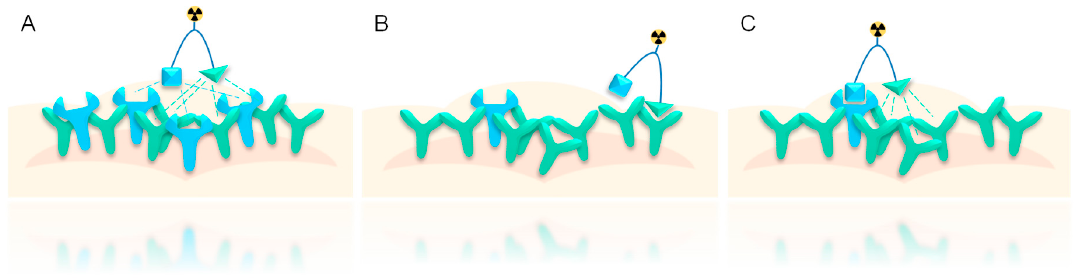
Figure 4. Schematic depiction of possibilities of avidity increase of heterodimeric peptides depending on receptor densities on the target cell. ( A ) Both target receptors are highly overexpressed, resulting in a high density of both receptor types and low distances between the different receptor types. ( B ) and ( C ) Only one of two receptors is strongly expressed, resulting in a high density of only one receptor type while the other is expressed in relatively lower density. In this case, the affinity of that part of the heterodimer is increased, which binds to the receptor expressed in lower density ( C ) while the affinity for the peptide binding to the strongly expressed receptor remains unaltered ( B ).